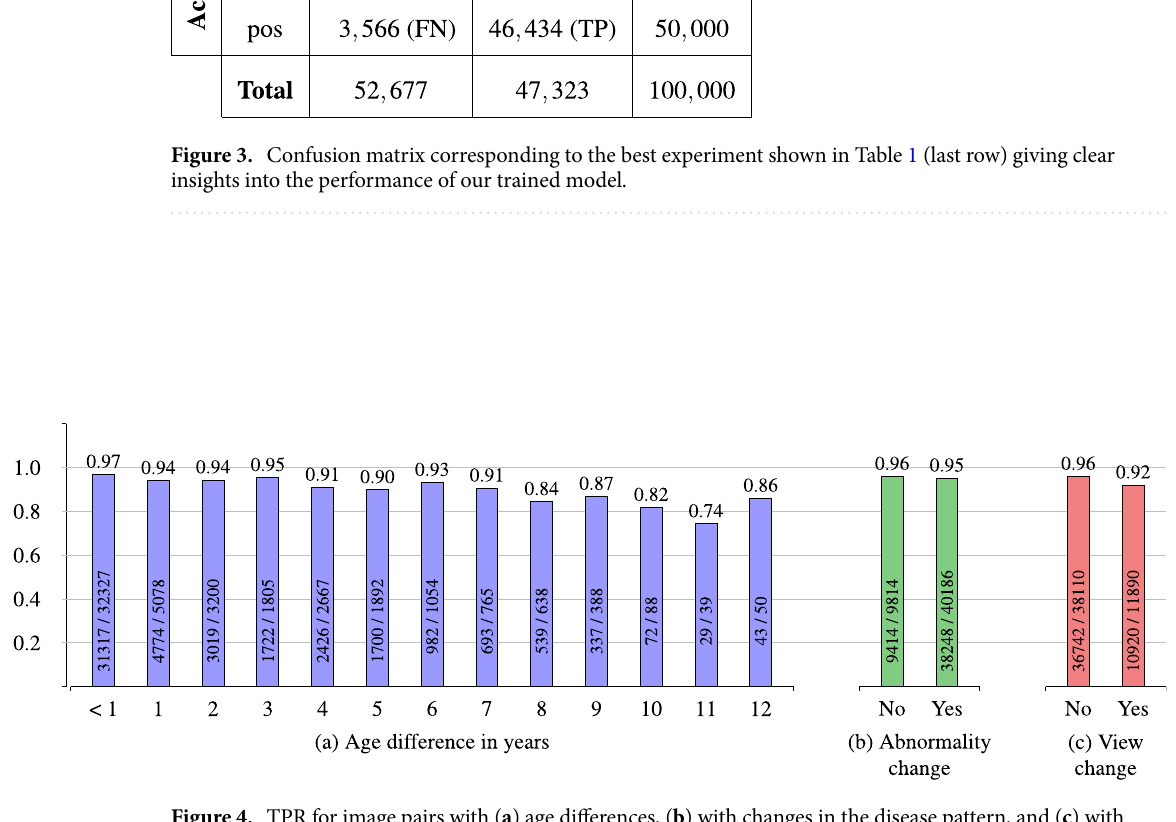
Figure 4. TPR for image pairs with ( a ) age differences, ( b ) with changes in the disease pattern, and ( c ) with changes in the projection view. The absolute numbers of true positives and overall positives are given for each bin. Note that the number of image pairs with age differences of more than 12 years is comparatively small, which is why the corresponding TPRs are neglected in this